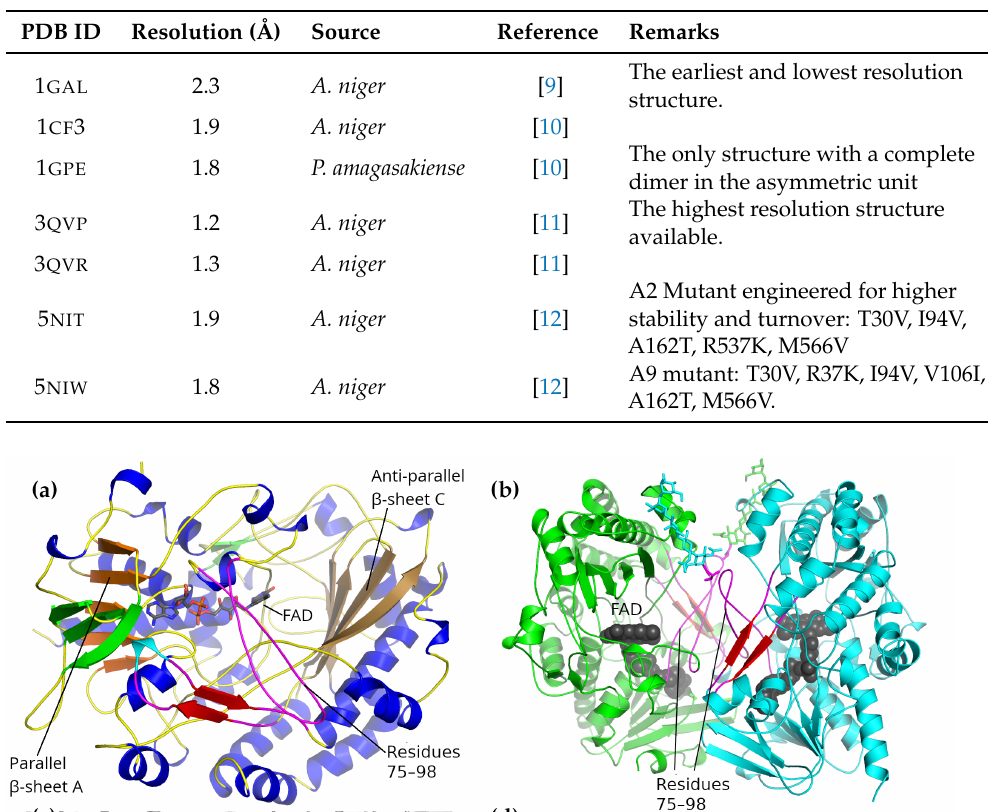
Table 1. Tertiary structures of glucose oxidase determined by X-ray crystallography.